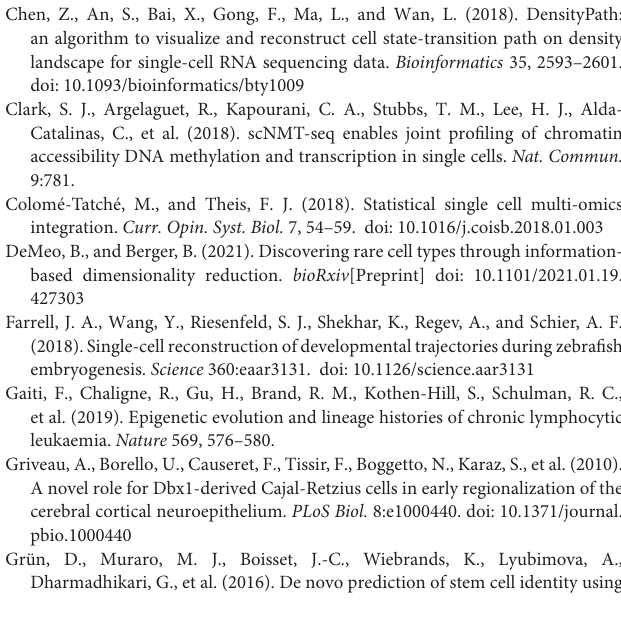
Supplementary Figure 7 | The 7-mer DNA sequence features trends (rank 1: red, rank 2: blue, rank 3: green) in HSC are shown from rank 1 to rank 3 by PTA analysis (A–D) . Here we only show the heatmap of DNA sequence features in rank 1. For each branch, we did down sampling using 20 as a group to compute the average signals as input of PTA. All7-mer DNA sequences in rank 1 are ranked by the PTA scores (values in the bar plot) from negative to positive. Negative value means that the z -score values are reverse to the trend. Positive value means that the z -score values are consistent with the trend. We set a threshold 0.03 to filter the DNA sequences with low absolute PTA scores and show the DNA sequence features with top 30 positive and smallest 30 negative scores. Prethalamic neuros (pTh.N), rostral thalamic neurons (rTh.N), zona limitans intrathalamica (ZLI), epithalamic neuros (ETh.N), rostral pretecal neurons (rPT.N), caudal thalamus Supplementary Figure 8 | Compare the trajectories of URD, Monocle2 and STREAM on the cerebellum, diencephalon, and HSC datasets. (A) Cerebellum trajectory built by Monocle2. (B) Diencephalon trajectory built by Monocle2. (C) Cerebellum trajectory built by URD. (D) HSC trajectory built by Monocle2 based on the z -scored scATAC-seq data. STREAM cannot work on the cerebellum and diencephalon datasets. The HSC trajectory from STREAM can be found in Chen H. et al. (2019). URD cannot work for the z -scored scATAC-seq dataset of HSC. The diencephalon trajectory built by URD can be found in Guo and Li (2019). Supplementary Figure 9 | Clustering visualization in UMAP on simulated dataset with different k size in kNN graph. As the k increases, the number of clusters decreases. Supplementary Figure 10 | Trajectory estimation for the simulated dataset using different k in kNN graph. The clustering was obtained by constructing the kNN graph followed by Leiden community detection. Then we applied LISA2 to obtain the final trajectory. The number of clusters decreases as the k size increase. Supplementary Table 1 | Compare running time (seconds) of L-ISOMAP in LISA and LISA2. The computer configurations are 64-bit Windows 8.1, Intel(R) Core i5-4210M CPU, and 8GB memory. Results were obtained using the same computer